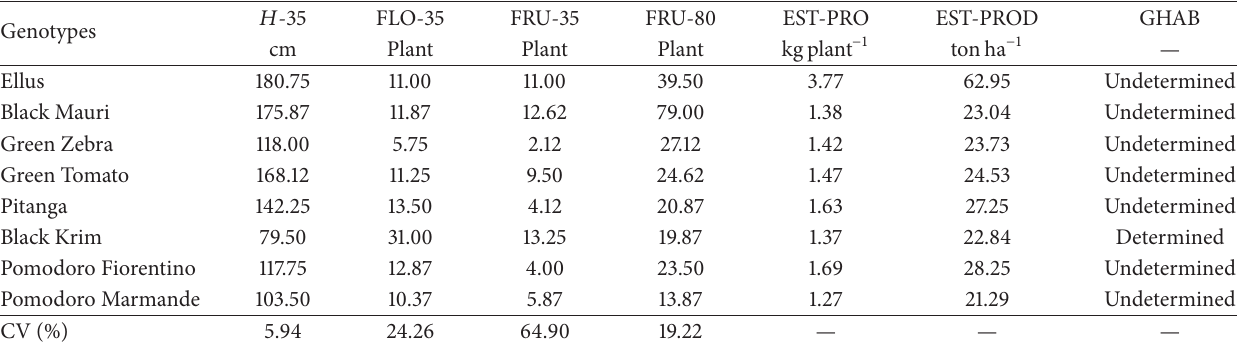
Table 1: Height 35 DAT ( 𝐻 -35), number of flowers 35 DAT (FLO-35), number of fruits 35 DAT (FRU-35), number of fruits 80 DAT (FRU-80), estimated production (EST-PRO), estimated productivity (EST-PROD), and growth habit (GHAB) of tomato genotypes.